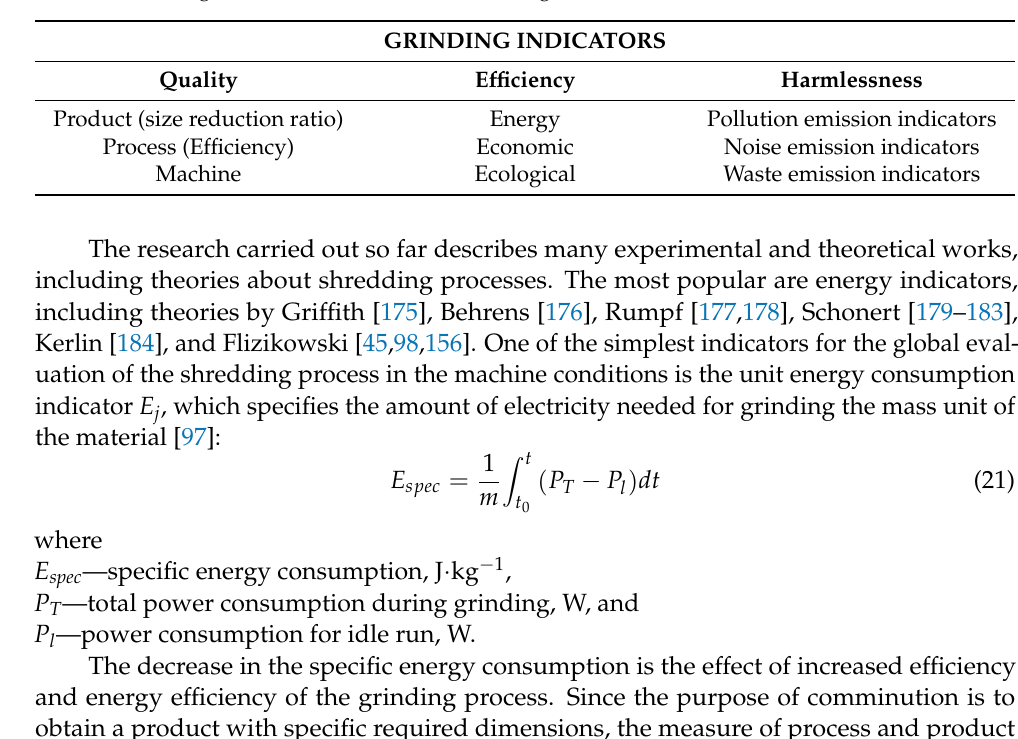
Table 7. Grinding indicators classification according to Flizikowski